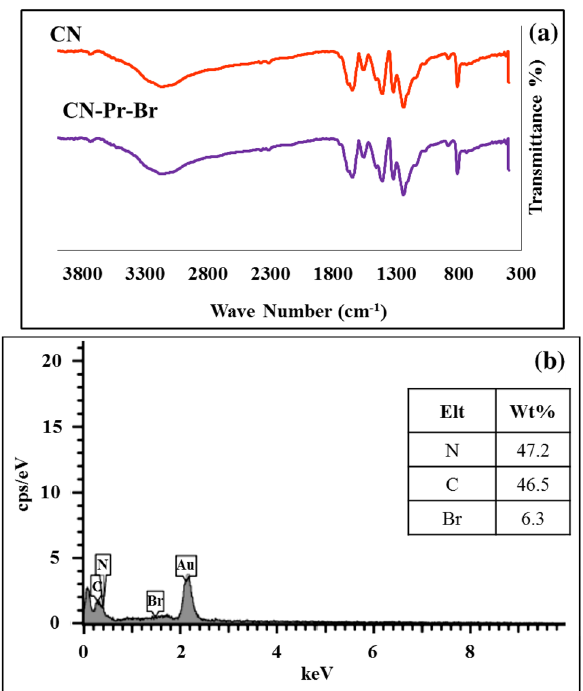
Figure 2. ( a ) FT-IR spectra of CN and CN-Pr-Br. ( b ) EDS analysis of